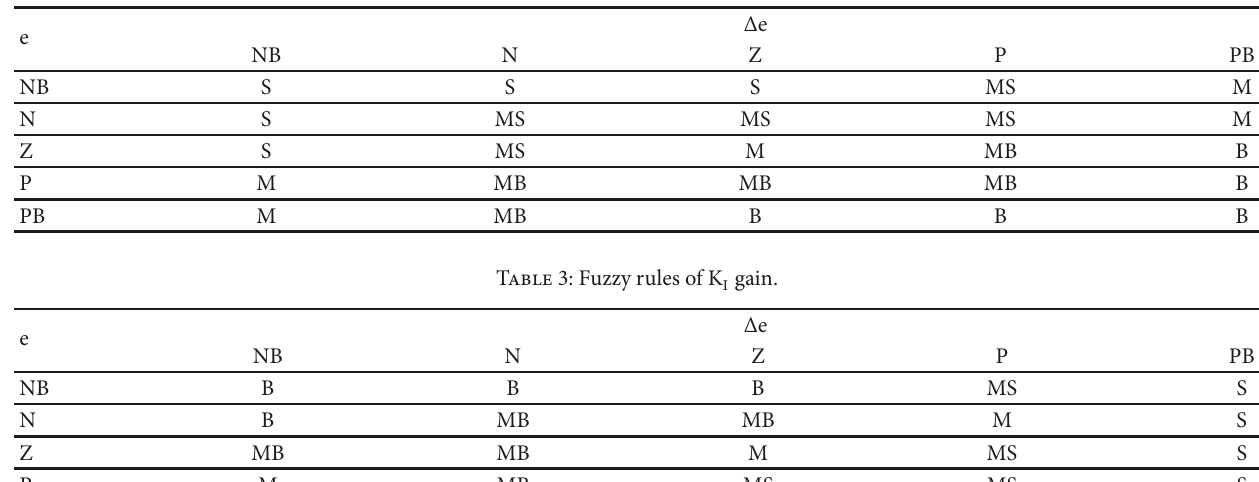
Table 2: Fuzzy rules of K P gain.